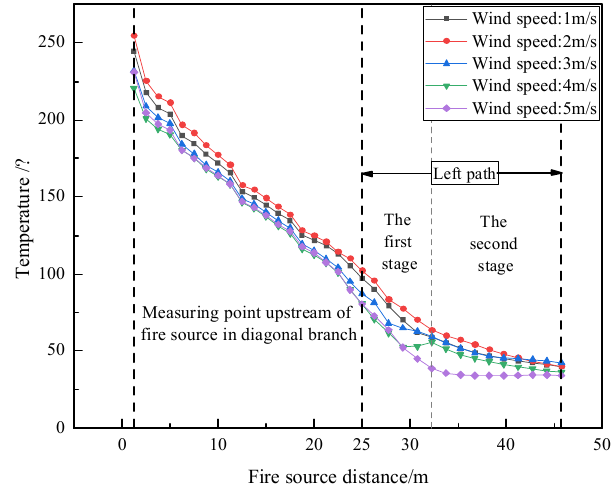
Figure 9. Temperature attenuation diagram of upstream measuring point of fire source.